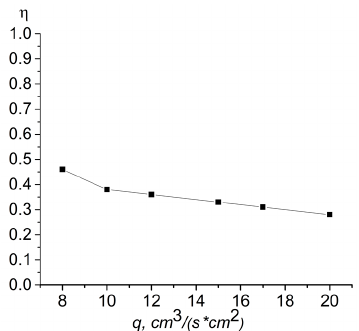
Figure 3. The e ff ect of nitrogen flow rate on the nitridation of powder of chromium. [N 2 ] = 100%. Figure 3. The effect of nitrogen flow rate on the nitridation of powder of chromium. [N 2 ]=100 %.